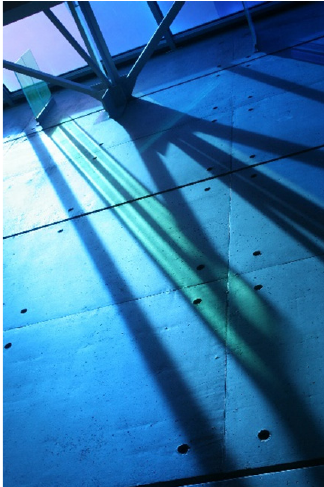
Figure 9. View of the worship space east wall at the end of the same 12:30 p.m. mass (Credit: Roberto Chiotti).